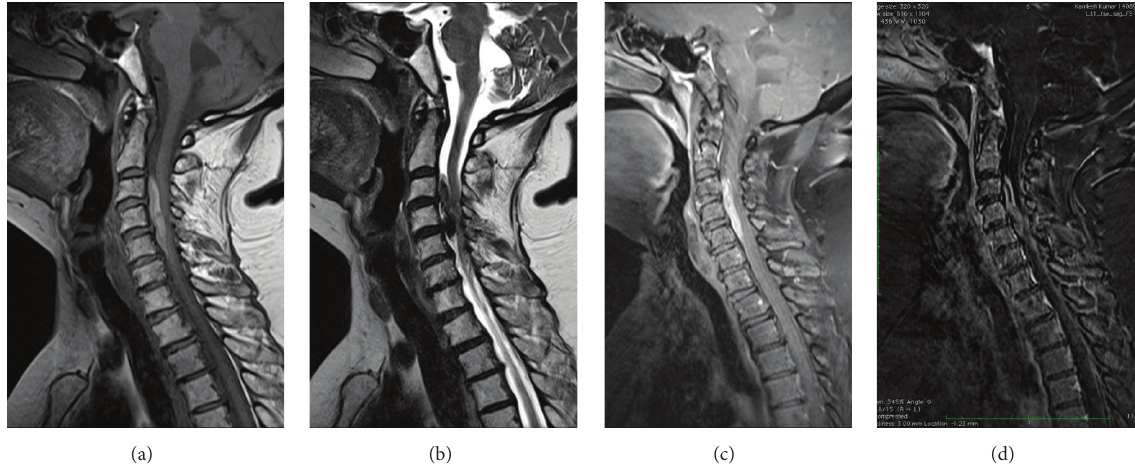
Figure 2: Sagittal sections of the cervical vertebral column: (a) T2 weighted and (b) T1 weighted images showing an intradural extramedullary mass which appears hypointense on T2 weighted image and hyperintense on T1 weighted image. (c) Postcontrast fat saturated T1 weighted and (d) subtracted contrast image showing mild peripheral heterogeneous enhancement of the tumor since the true enhancement pattern was obscured by the strong T1 hyperintensity of the mass on unenhanced images.